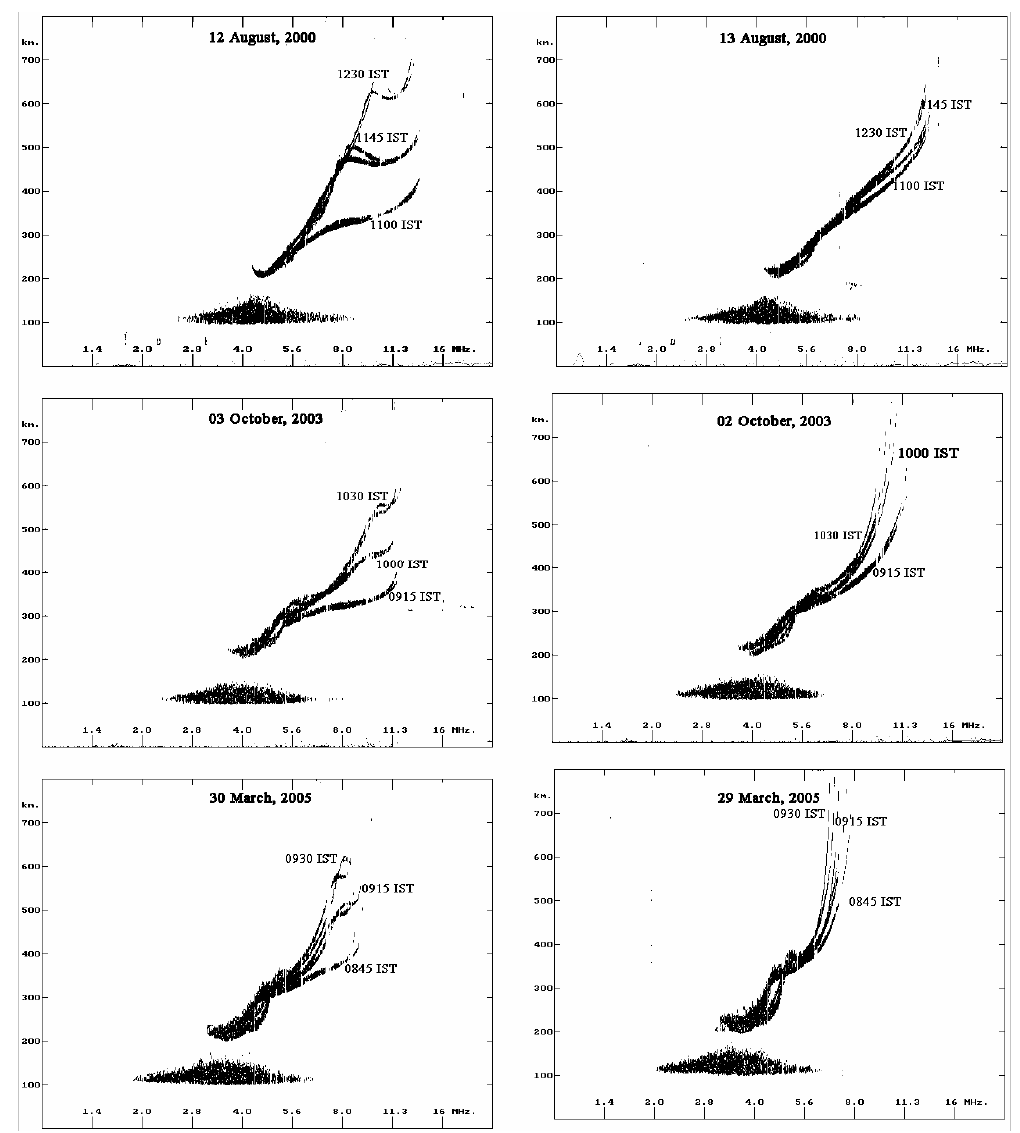
Fig. 1a. Left panel: sample ionograms illustrating the temporal evolution of F3 layer at Trivandrum on different days. Right panel: sample ionograms at the corresponding times when F3 layer is